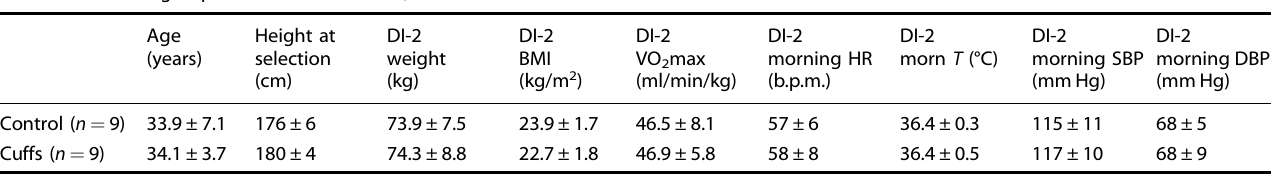
Table 1. Baseline group characteristics at DI-2, mean ±